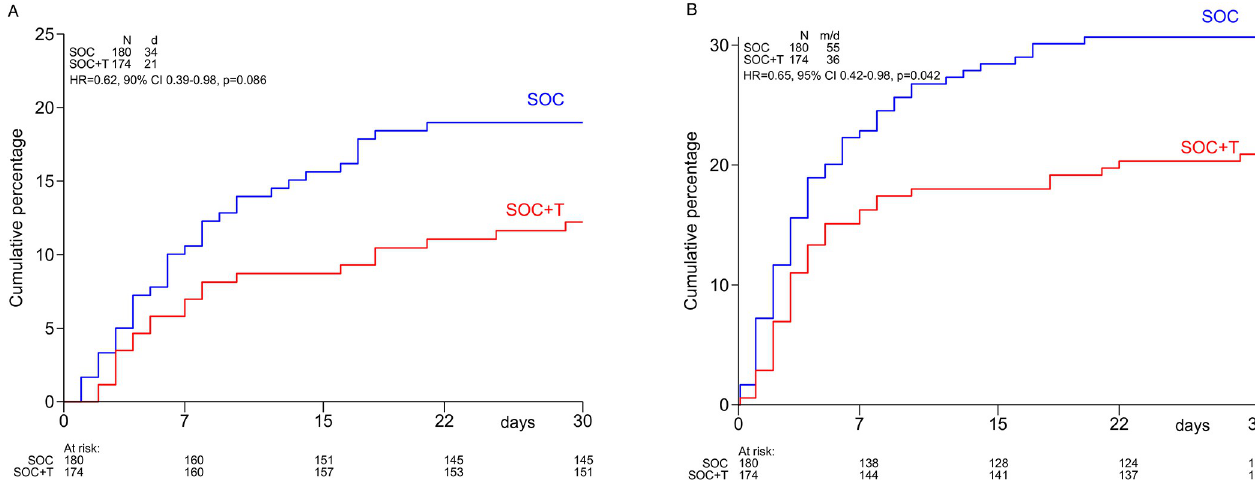
Fig 2. A . Mortality by treatment arm. SOC = standard of care, SOC+T = standard of care plus tocilizumab, N = number of patients, d = number of deaths, HR = hazard ratio, CI = confidence interval. B . Mechanical ventilation or death by treatment arm. SOC = standard of care, SOC+T = standard of care plus tocilizumab, N = number of patients, m/d = number of patients with mechanical ventilation or death, HR = hazard ratio, CI = confidence interval.